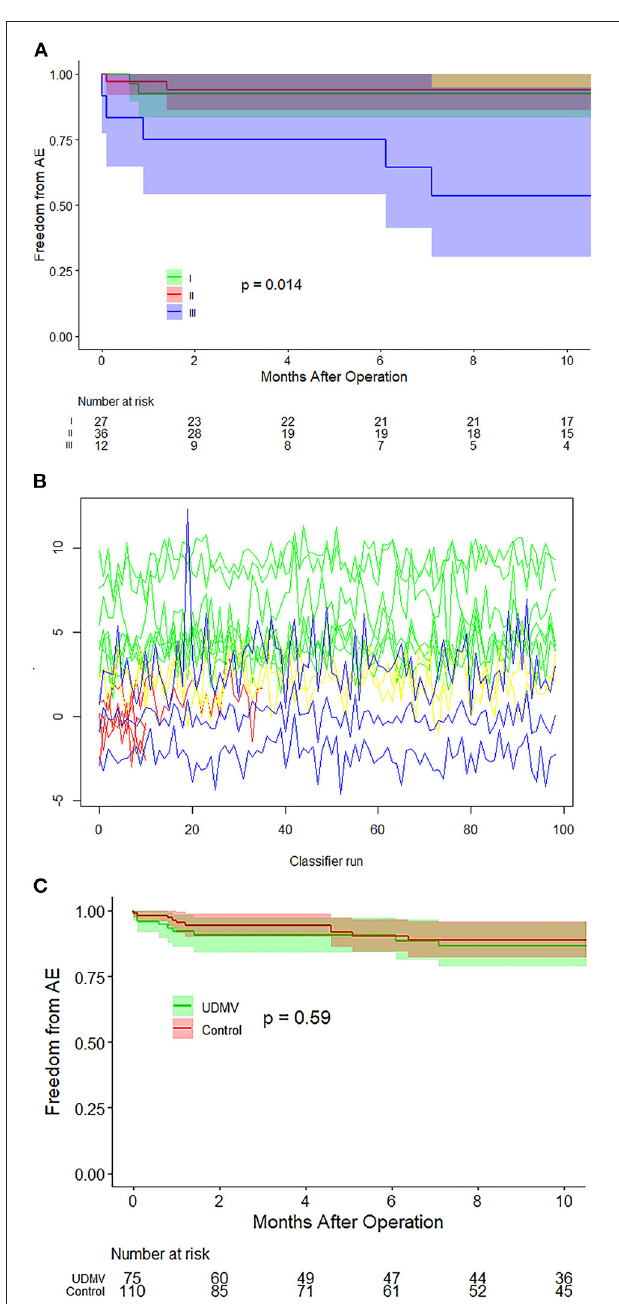
FIGURE 3 | Survival curves and random forest model. (A) Survival curves of the three classes of UCMV show that class III is associated with a higher incidence of adverse events. (B) The random forest model proved the classification to be of great importance in the prediction of adverse event risk. (C) Survival curves of the UCMV and control groups show that there is no significant difference in the surgical prognosis between the UCMV and control groups ( p = 0. 59). UCMV, undifferentiated chordae tendineae of the mitral valve.